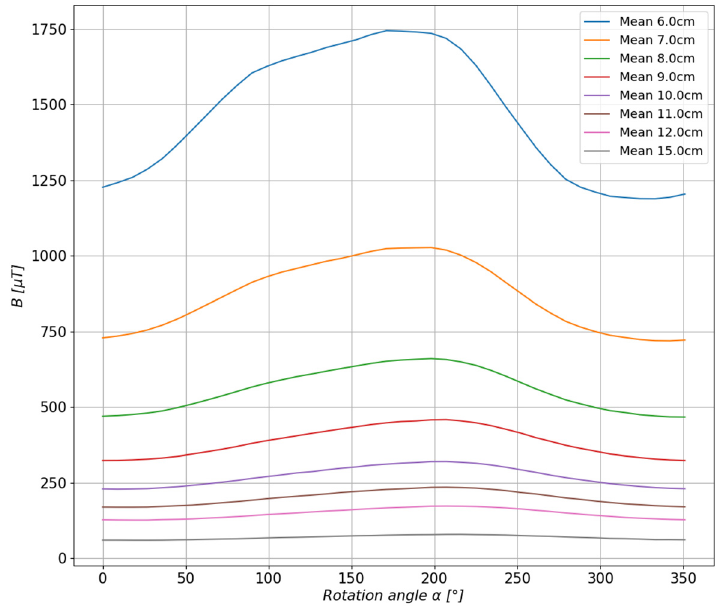
Figure 15. Summary of the measured mean values of the total magnetic induction B of a ferrite toroidal magnet.